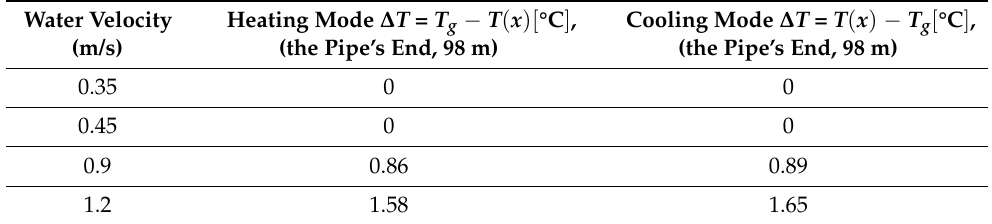
Table 4. Comparison of model heat transfer performances in heating and cooling modes.